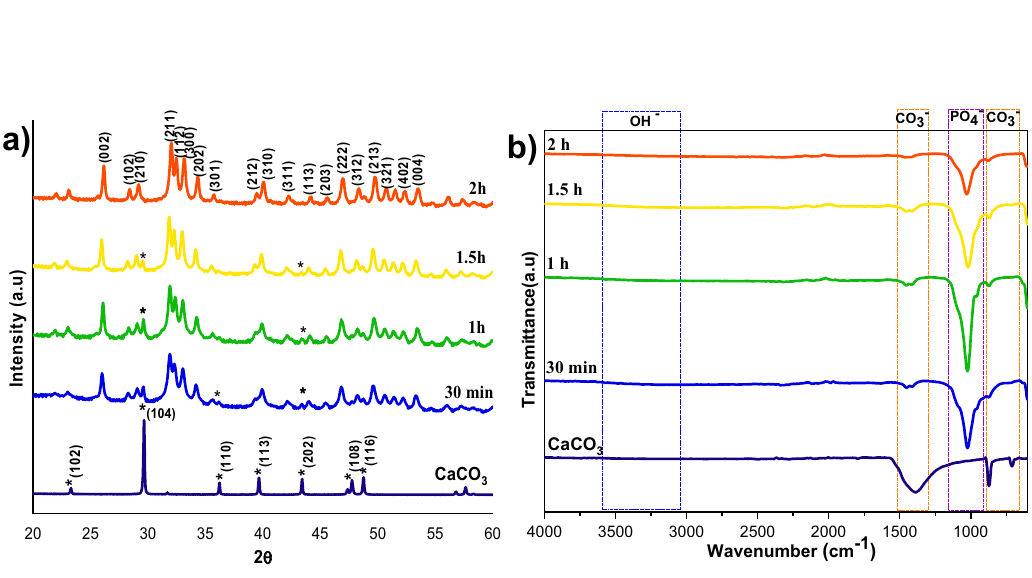
Figure 4. XRD ( a ) and FTIR ( b ) spectra of HAp prepared at different reaction